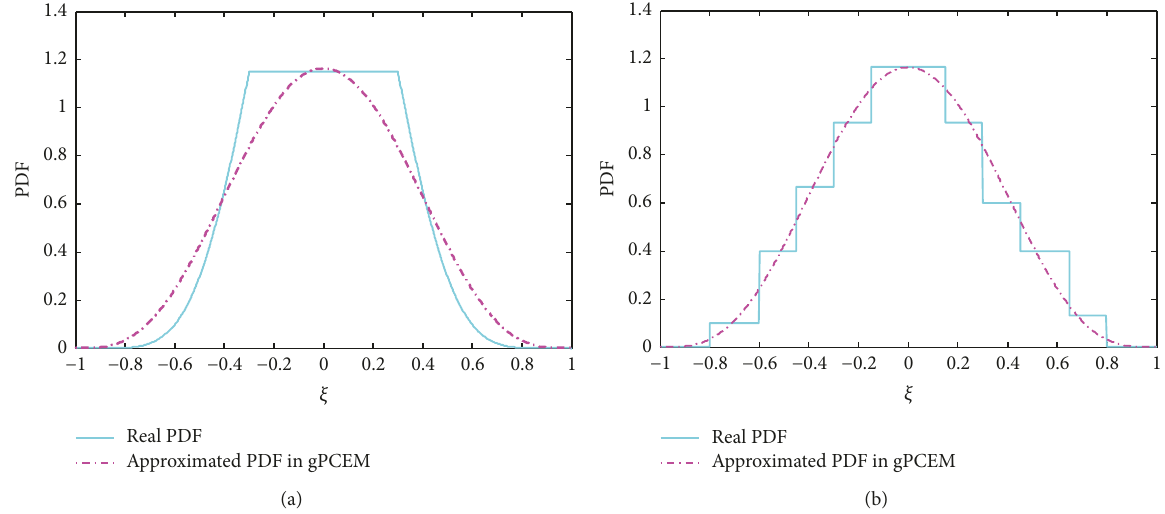
Figure 7: The original PDF of random variables and the approximated PDF in gPCEM: (a) 𝜉 4 and (b) 𝜉 5 .